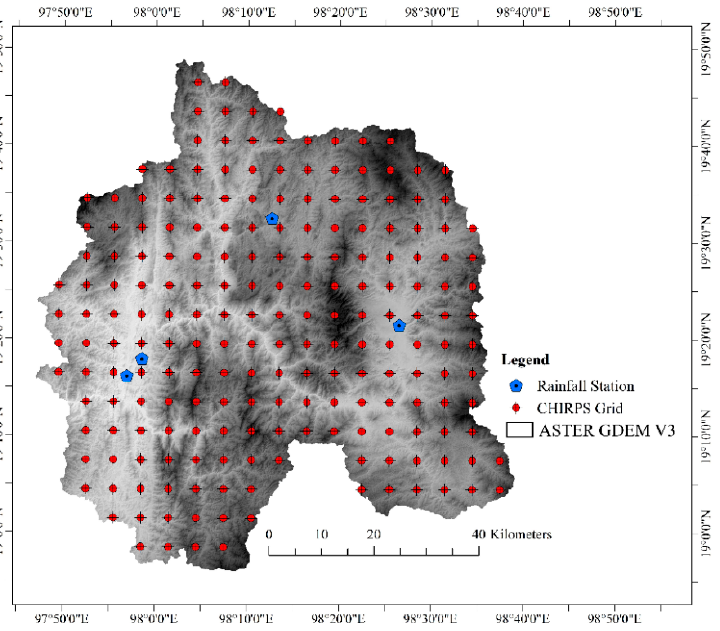
Figure 3. ASTER GDEM V3, location of rain gauges, and the grid of CHIRPS for this